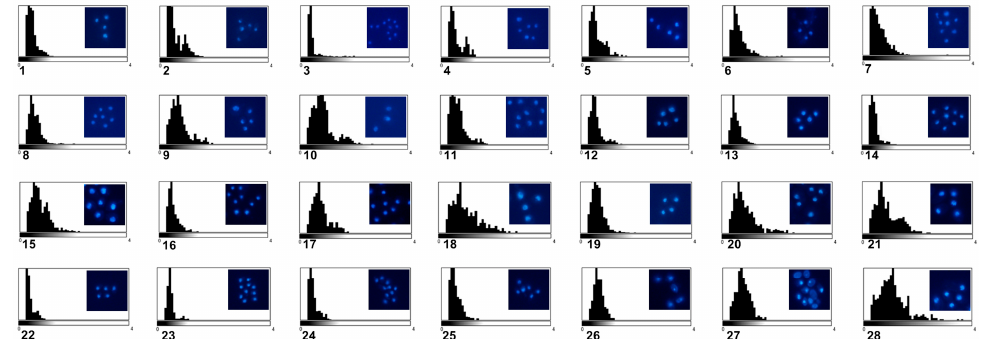
Figure 2. Fluorescence microscopy-based analysis of DNA content. Fixed cells ( n = 100) were analyzed using an Olympus BX61 fluorescence microscope equipped with a DP72 CCD camera and Olympus CellF software (Olympus, Warsaw, Poland). For DNA visualization, the slides were counterstained with a drop of mounting medium containing 4 ′ ,6 ′ -diamino-2-phenylindole (DAPI) (blue). DNA content of clinical Candida isolates were compared to reference strains, namely haploid (26), diploid (27), and tetraploid (28) strains. DNA content was expressed as arbitrary units (relative fluorescence units from 0 to 4). Representative microphotographs and data distribution (histograms) are shown. C. albicans group (1, 2, and 4–19), C. tropicalis group (20, 21), C. glabrata group (3 and